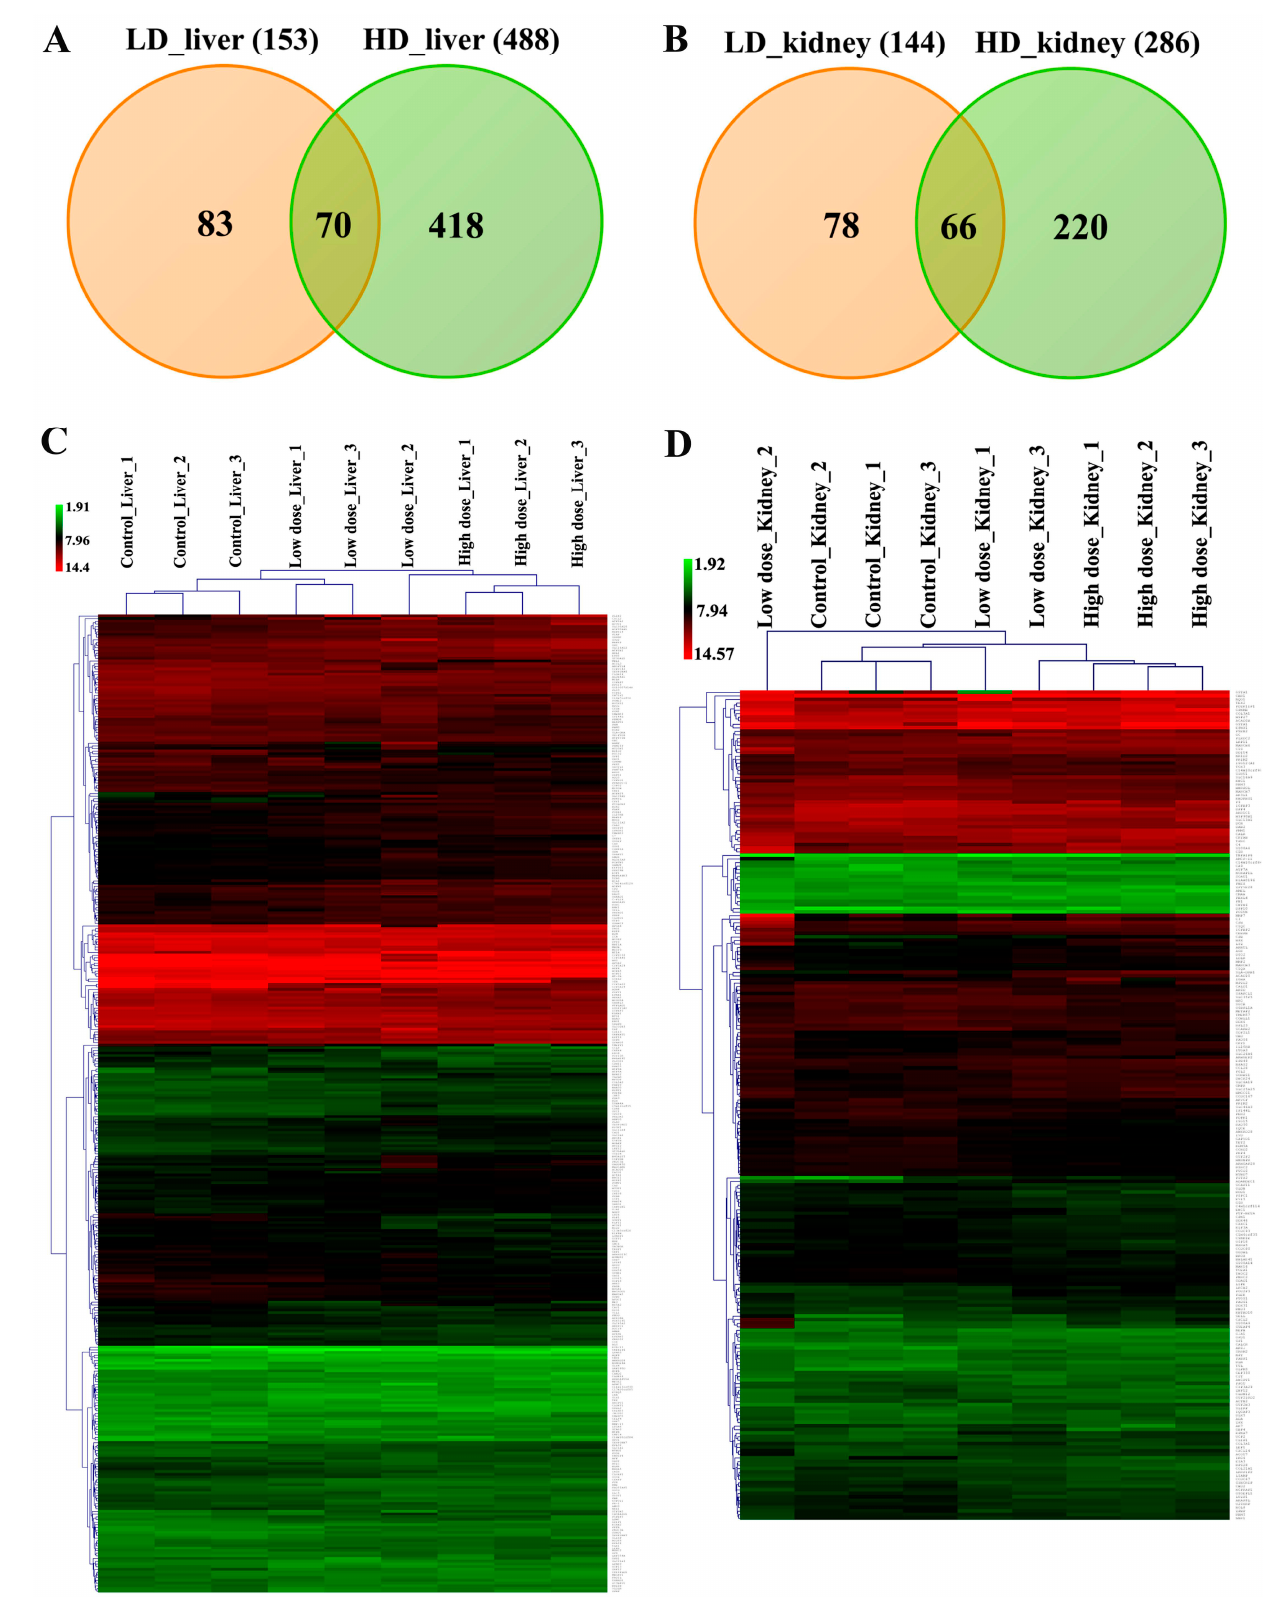
Figure 7. Differentially expressed genes after low- and high-dose diclofenac treatment. Panel A : Venn diagram of liver DEGs after low- (3 mg/kg/day) and high-dose (15 mg/kg/day) treatment. A